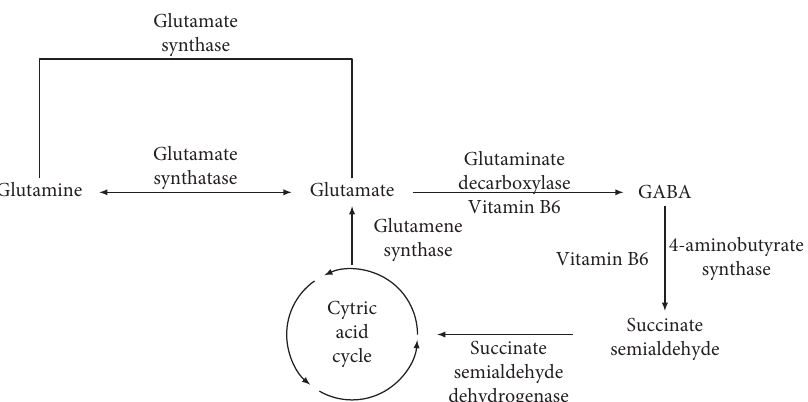
Figure 3: The metabolic pathway of the transformation of glutamate to GABA via the glutamate decarboxylase enzyme and vitamin